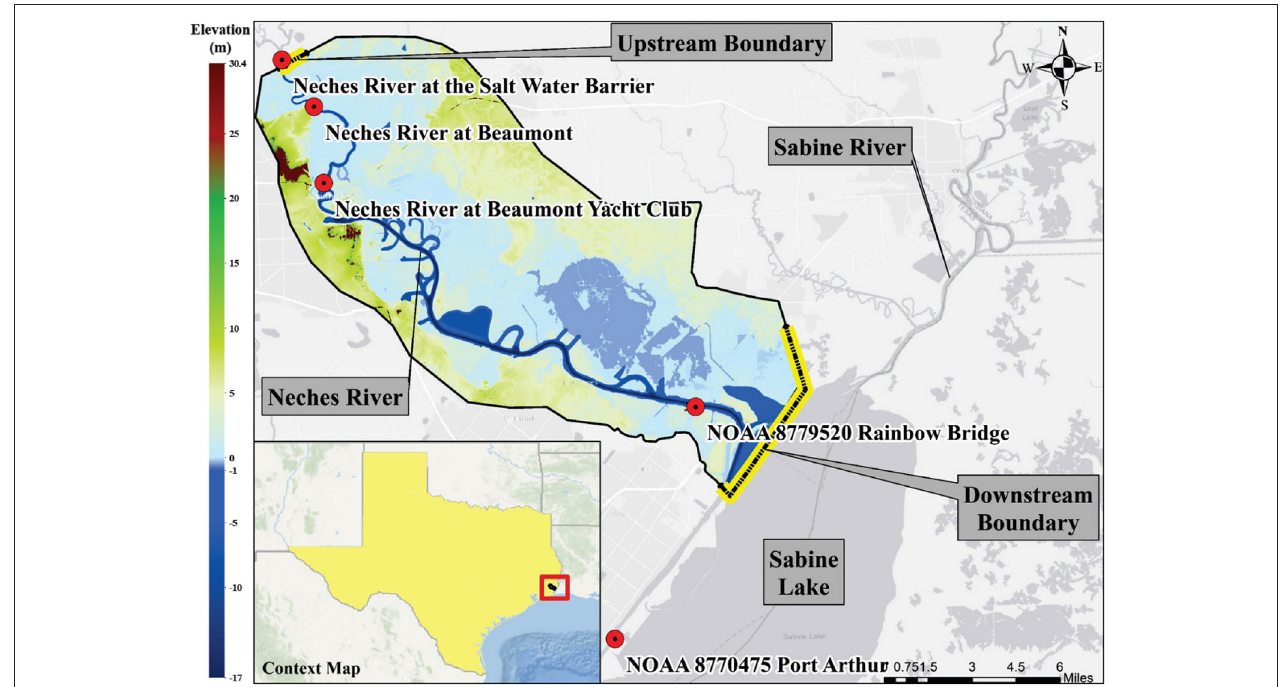
FIGURE 1 | Lower Neches River watershed and Sabine River and Sabine Lake locations. The color-coded figure shows the bathymetry and land elevation. The HEC-RAS domain is outlined in black. Location of gages demarcated by red dots.